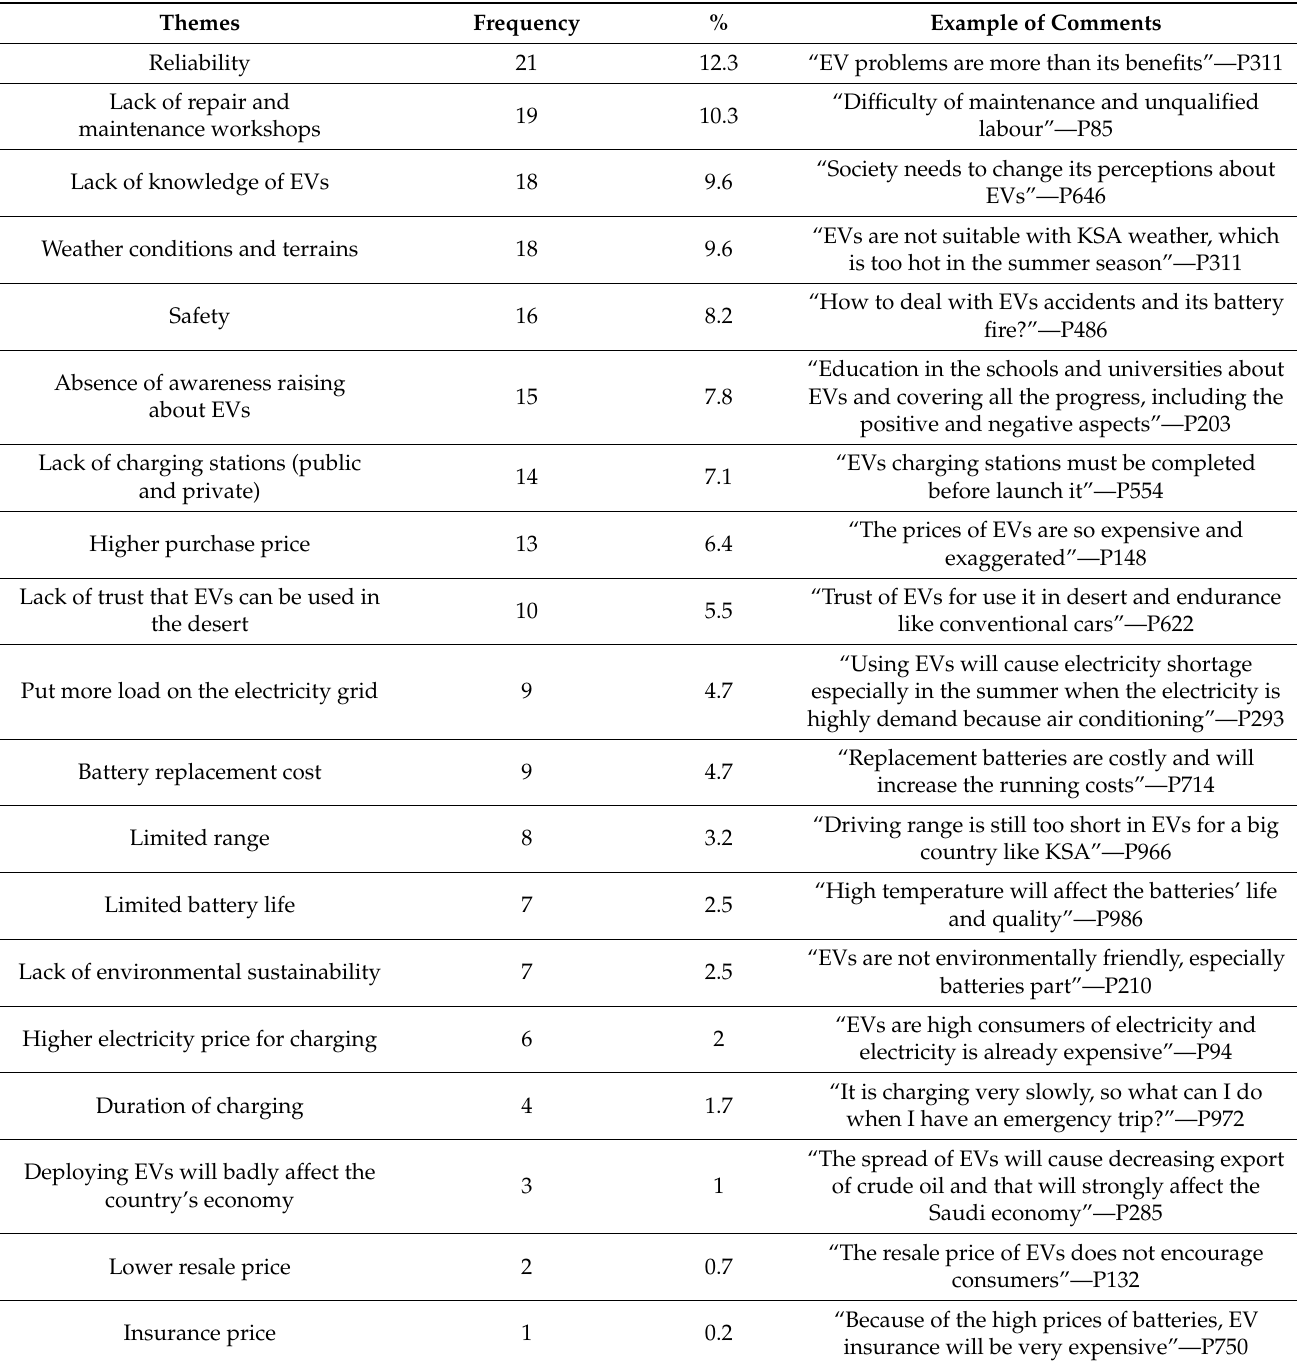
Table 9. Thematic analysis of the barriers to EV